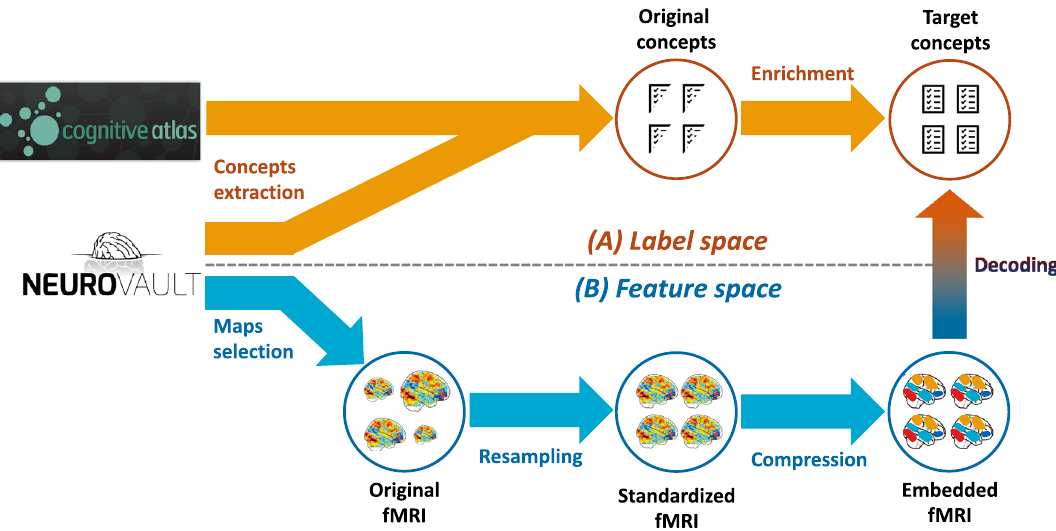
Figure 1. Approach for public data decoding. Part ( a ) extracts cognitive concepts from the annotations as labels and part ( b ) extracts the associated features from NeuroVault fMRI maps. ( a ) In the label space: we extracted any concept of Cognitive Atlas that we find in the annotations, then we enriched those using either imputation rules or similarities learned from an external source, which yielded several labels for each fMRI map. ( b ) In the feature space: we first selected the usable fMRI maps from NeuroVault, standardized them to a common resolution and brain mask, then we projected them on a dictionary of brain components extracted from a huge number of brain activation maps. Finally, we trained models to decode the concepts of ( a ) from the maps of ( b ).